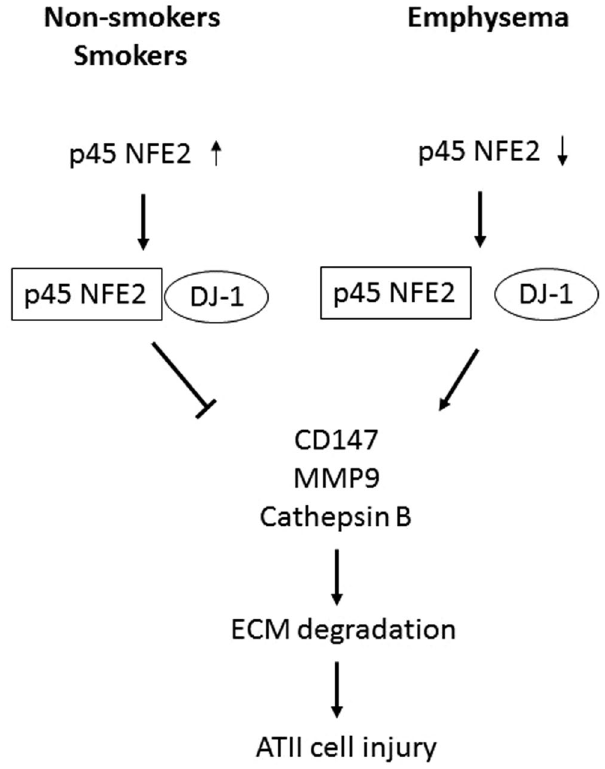
Figure 6. The role of p45 NFE in ATII cells in non-smokers, smokers and emphysema